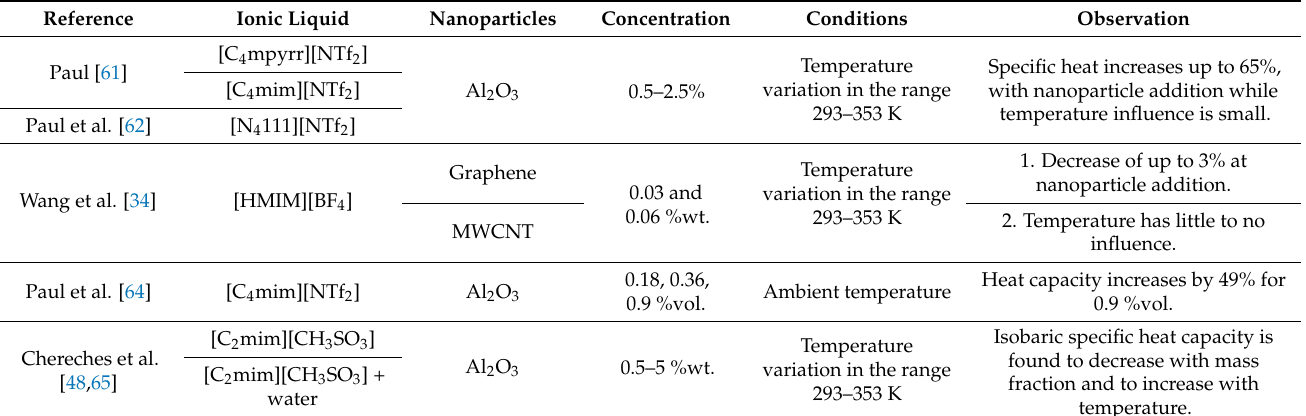
Table 5. Literature results on specific heat of ionic liquid-based